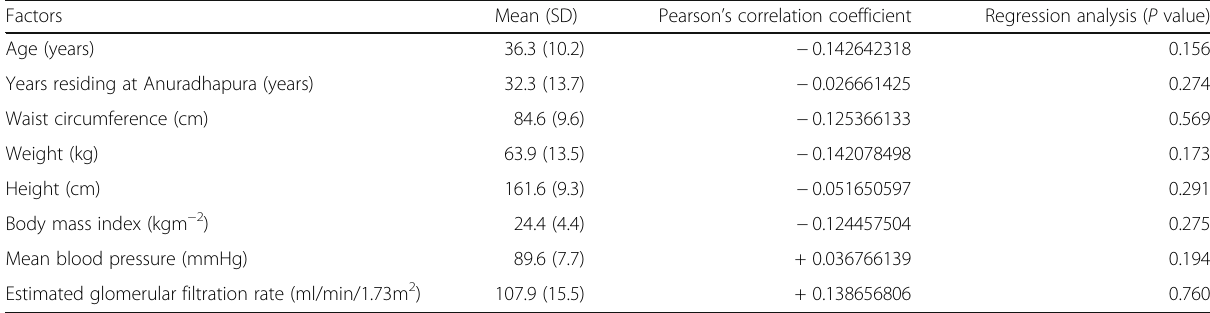
Table 1 Possible determinants of red blood cell acetylcholinesterase activity among healthy, non-farmers of Anuradhapura, 2017